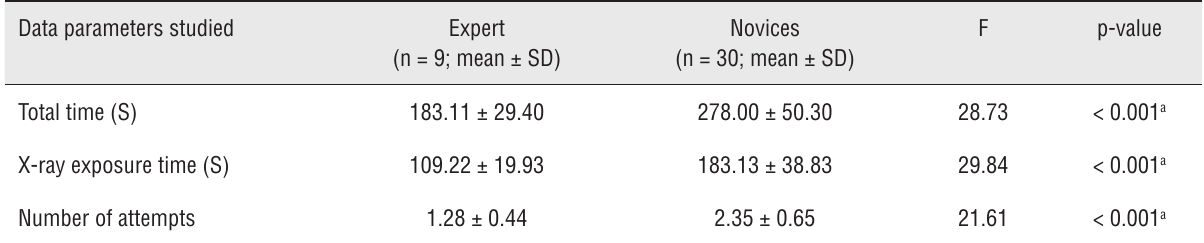
Table 2 - Construct validity (experts and novices).